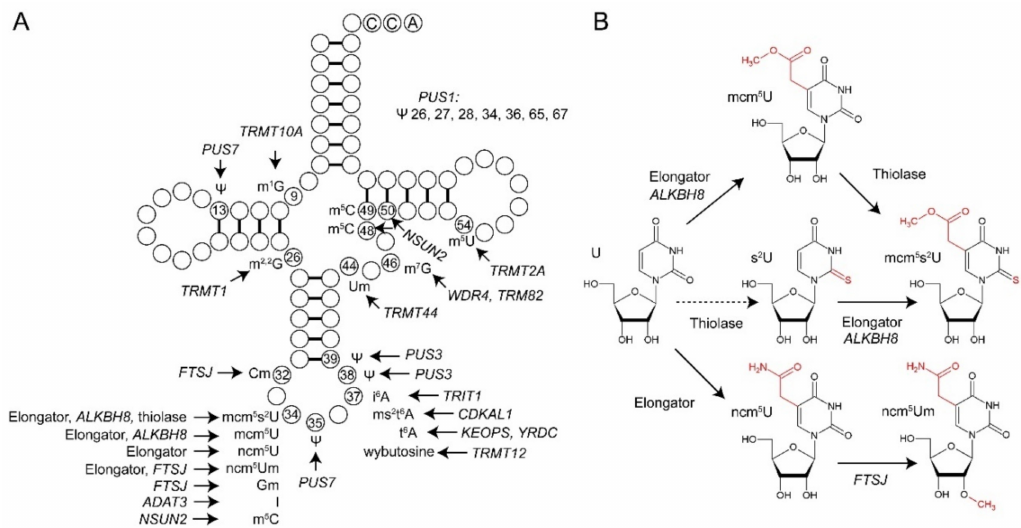
Figure 1. Transfer RNA (tRNA) modifications associated with human disease. ( A ) Schematic representation of a cytoplasmic tRNA with disease linked modifications at indicated base positions. Modification genes linked to human diseases when mutated or upregulated are denoted (see Table 1 and references therein for details). ( B ) Overview of steps and genes involved in xm 5 U 34 synthesis. A broken line between U 34 and s 2 U 34 indicates the fact that several lines of evidence support preferential action of the thiolase on mcm 5 U 34 rather than unmodified U 34 . Elongator specifies different subunits of the Elongator complex, whereas thiolase represents the complex composed of subunits CTU1 and CTU2. Abbreviations for U 34 modifications are according to the modomics database